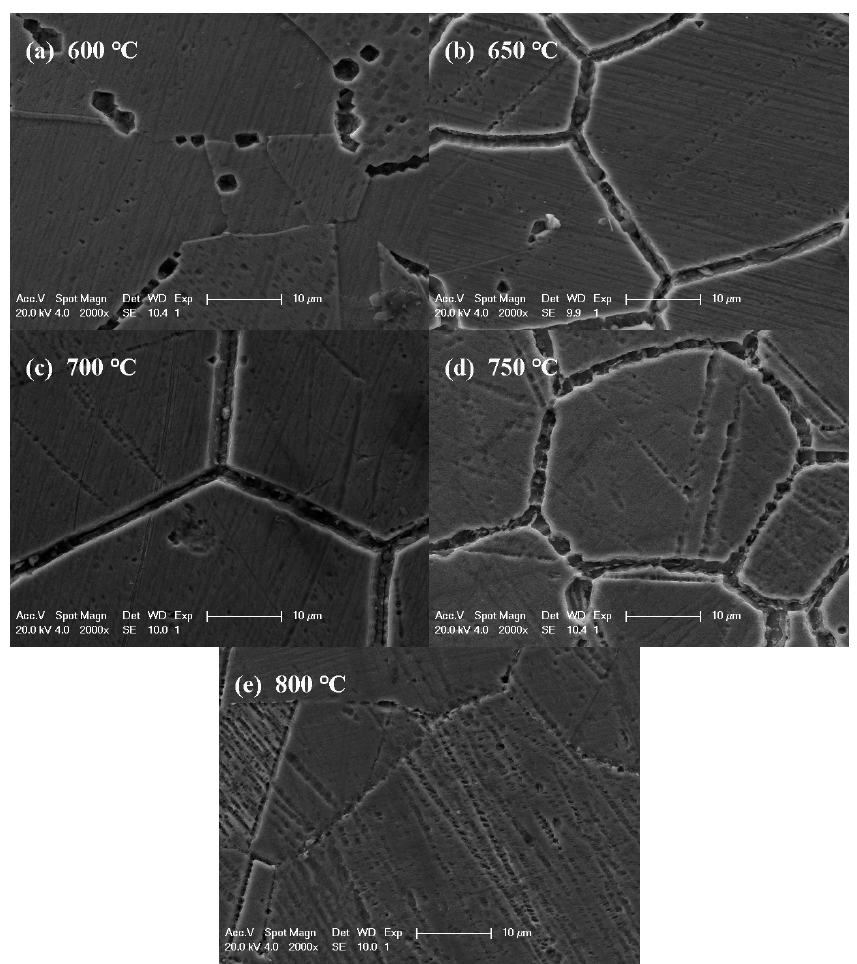
Figure 6. The SEM figures of Cr–Mn–Ni–N–Cu austenitic stainless steel samples treated at different temperatures for 300 min after the DL-EPR test: ( a ) 600 °C; ( b ) 650 °C; ( c ) 700 °C; ( d ) 750 °C; ( e ) 800 °C.